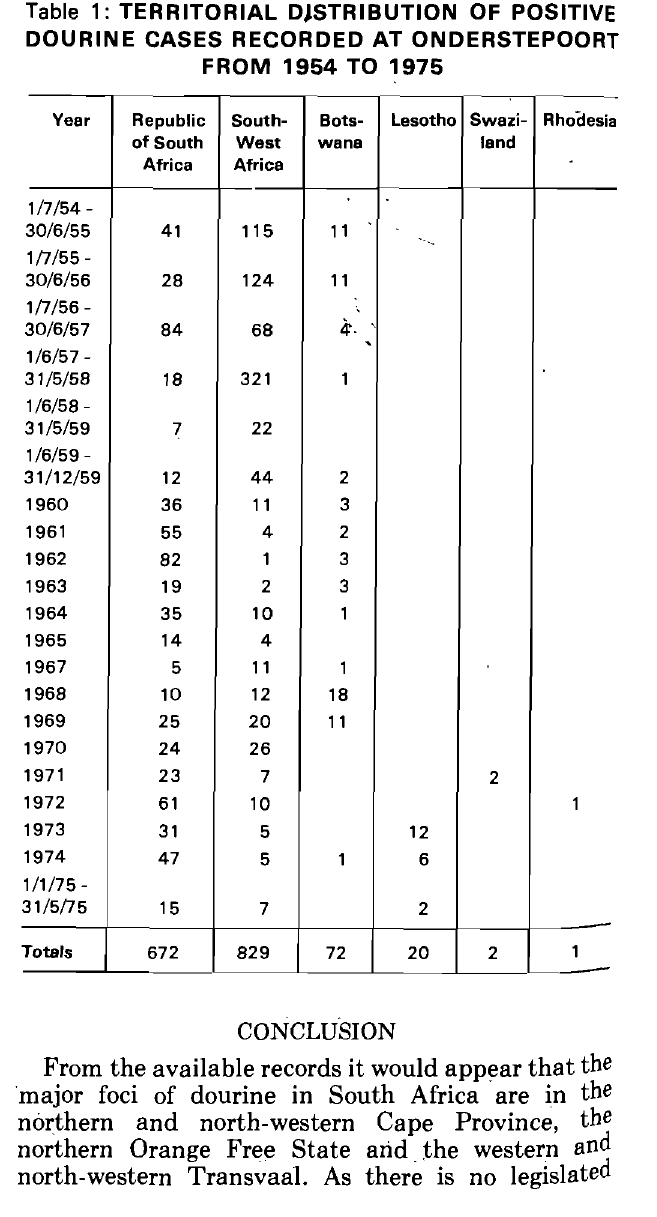
Table 1: TERRITORIAL DJSTRIBUTION OF POSITIVE DOURINE CASES RECORDED AT